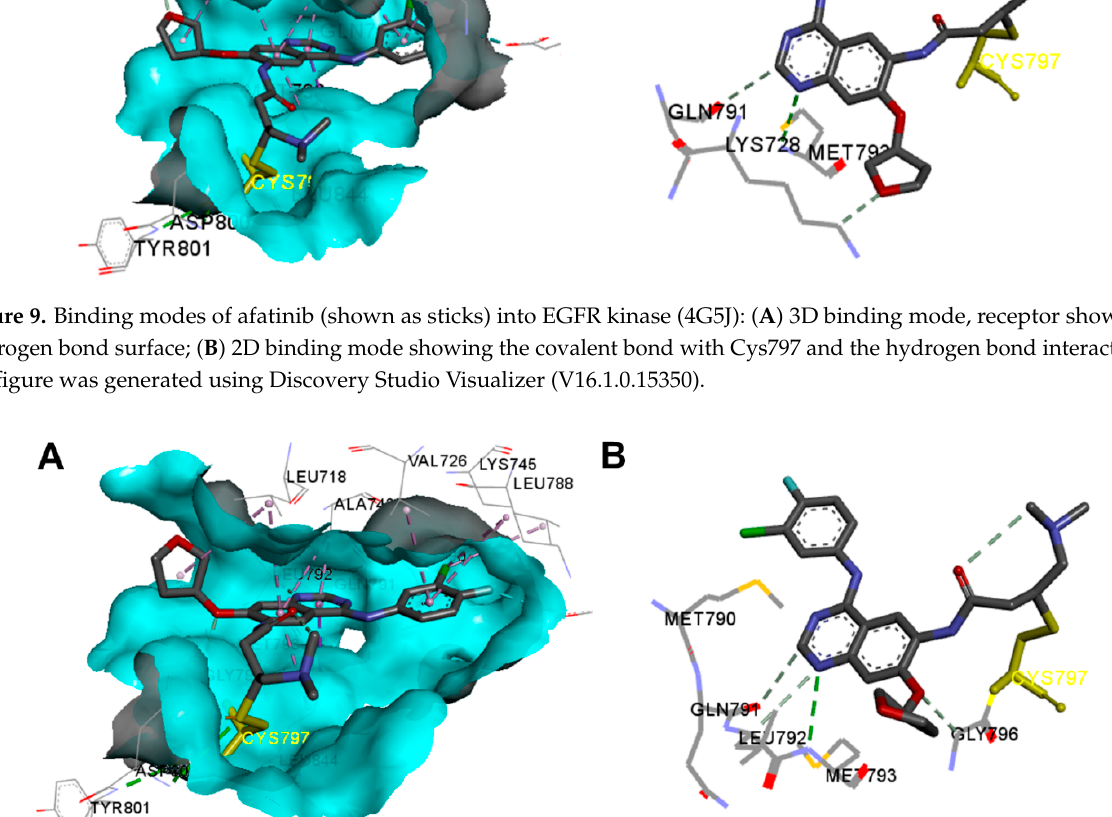
Figure 10. Binding modes of afatinib (shown as sticks) into EGFR kinase T790M (4G5P): ( A ) 3D binding mode, receptor shown as hydrogen bond surface; ( B ) 2D binding mode showing the covalent bond with Cys797 and the hydrogen bond interactions; the figure was generated using Discovery Studio Visualizer (V16.1.0.15350).